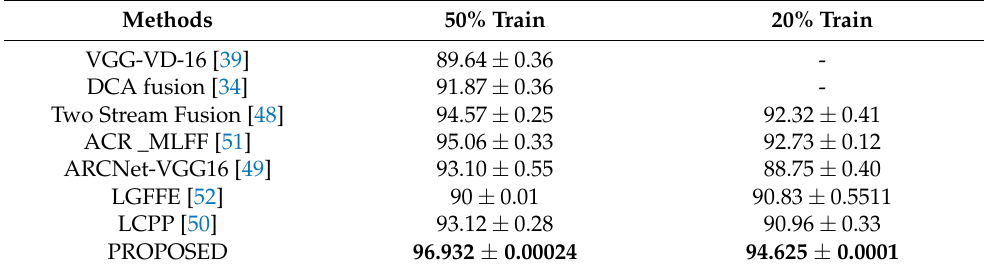
Table 5. Overall accuracy and standard deviation of the proposed method and comparison ap- proaches on the AID data set.